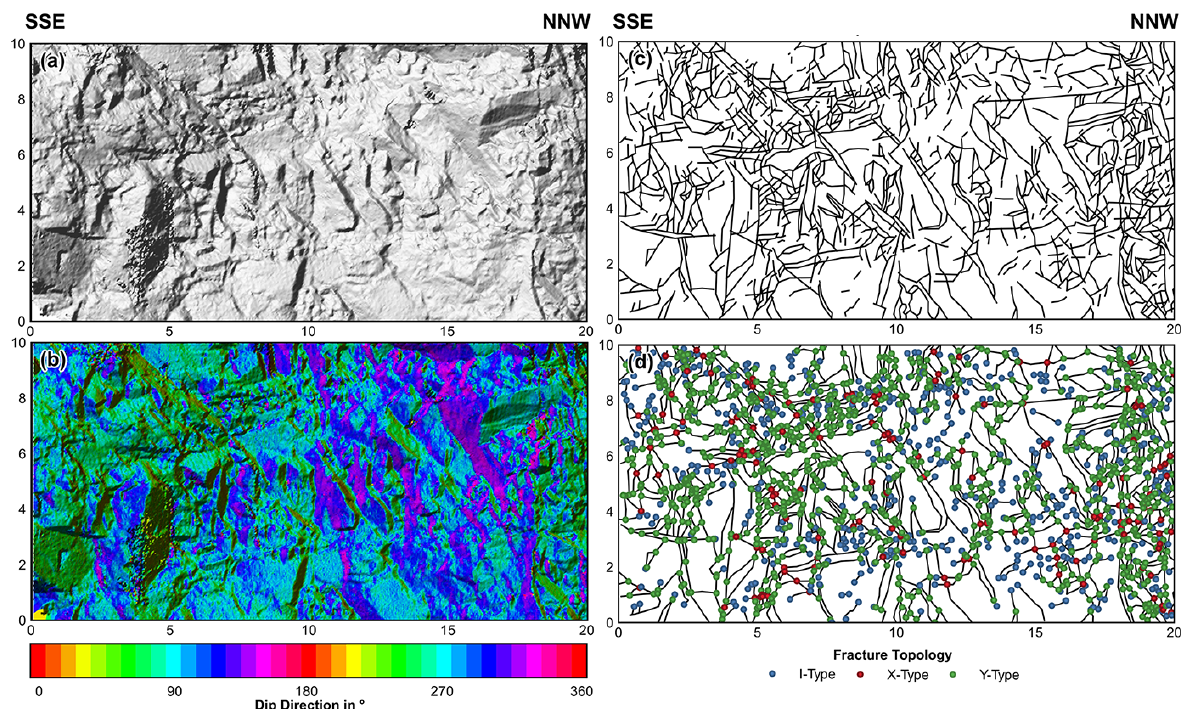
Figure 3. Interpretation of a scanned outcrop wall from the quarry in Ober-Mengelbach (Profile A in Fig. 2): (a) rasterized side view; (b) calculated dip direction; (c) manually interpreted fracture traces; (d) topology of the fracture